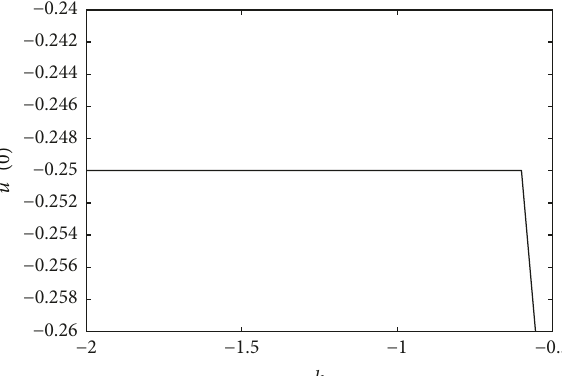
Figure 5: The approximate optimal ℎ ( ℎ = −1.1 ) for 𝑁 = 10 for Example 2.